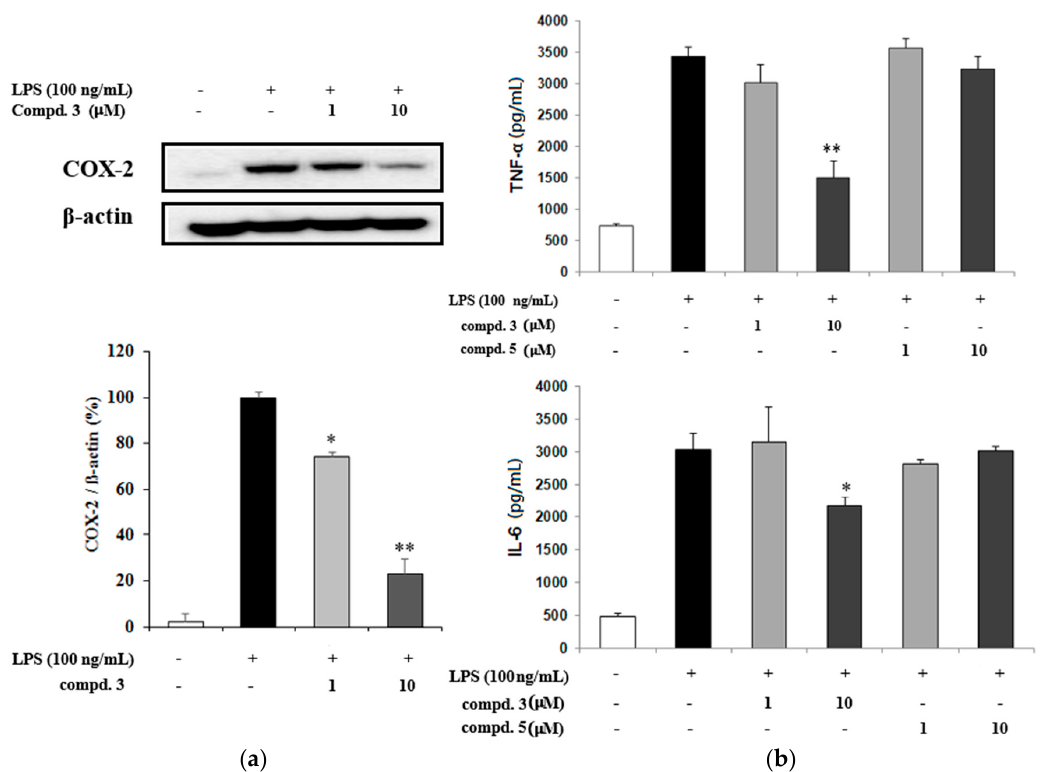
Figure 3. ( A ) The expression of COX-2 in LPS-activated BV2 microglia. The relative expression levels of COX-2 were determined by densitometry and normalized by actin; ( B ) The effects of compounds 3 and 5 on TNF- α and IL-6 secretion in LPS-activated BV2 microglia. Results represent the mean ± SD of three independent experiments. Results differ significantly from the LPS-treated, * p < 0.05, ** p < 0.01. +: sample treated, − : no treated.